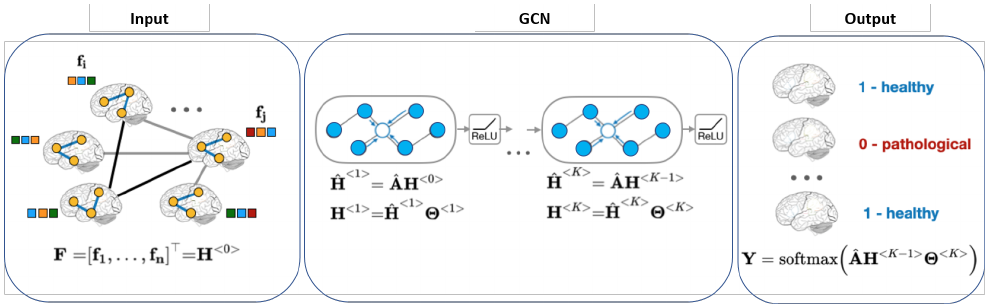
Figure 5. Proposed population graph-based approaches for subject classification. Image taken from